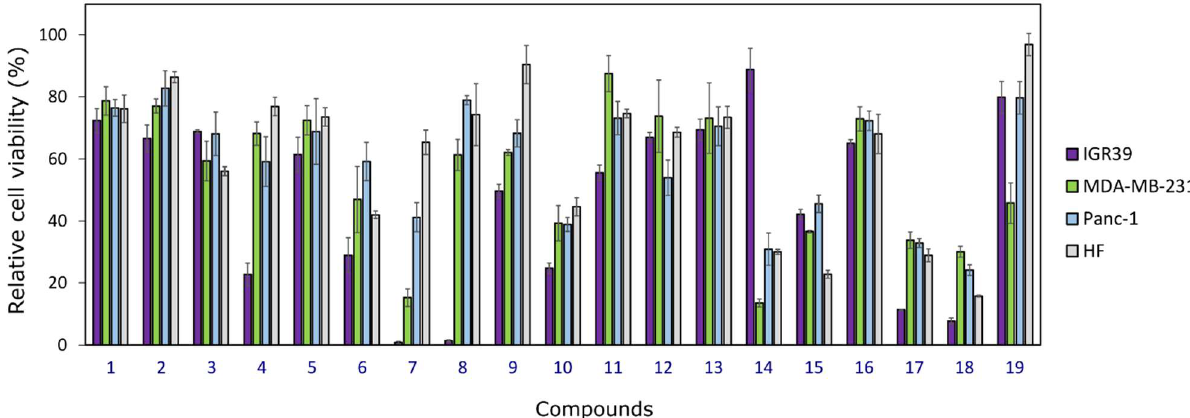
Figure 1. Effect of hydrazones 1–19 on cancer cell viability at a concentration of 50 µM against human melanoma IGR39, human triple-negative breast cancer MDA-MB-231, human pancreatic carcinoma Panc-1 cell lines, and human fibroblasts HF; n = 3.